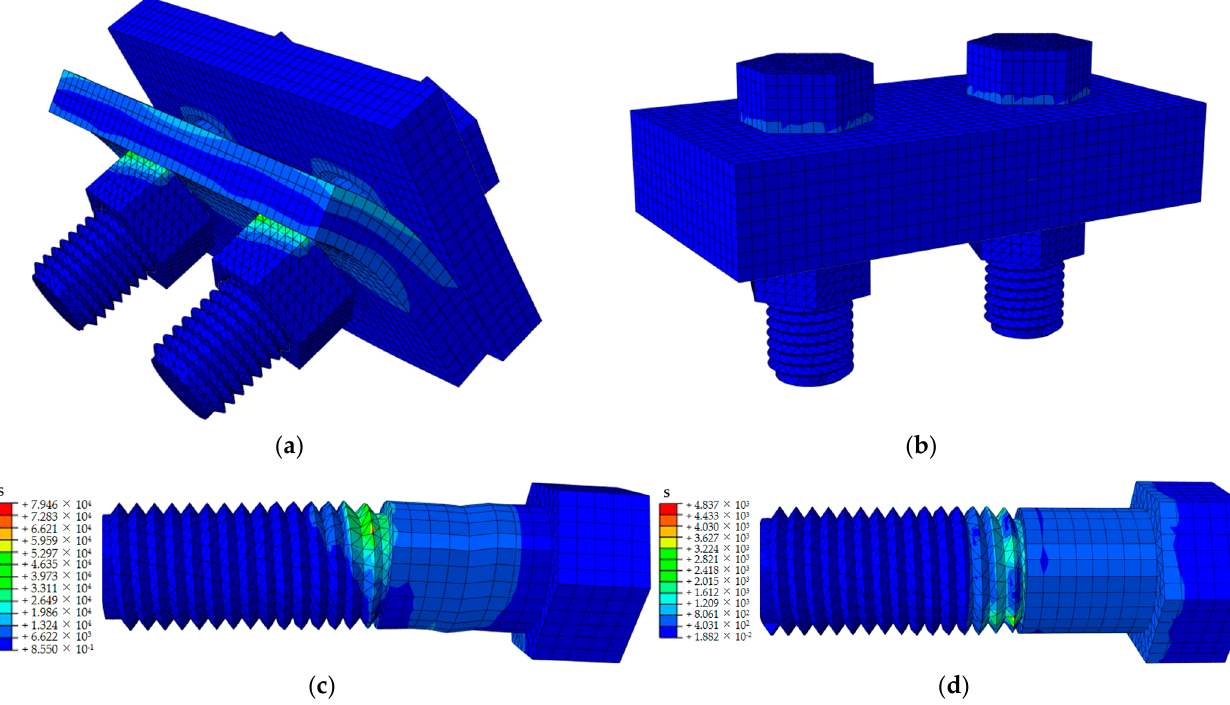
Figure 8. Bolt Stress Results: ( a ) Model stress nephogram under linear load; ( b ) Model displacement nephogram under seismic load; ( c ) Stress simulation diagram of UDHSB under linear load; ( d ) Stress simulation diagram of UDHSB under seismic load.